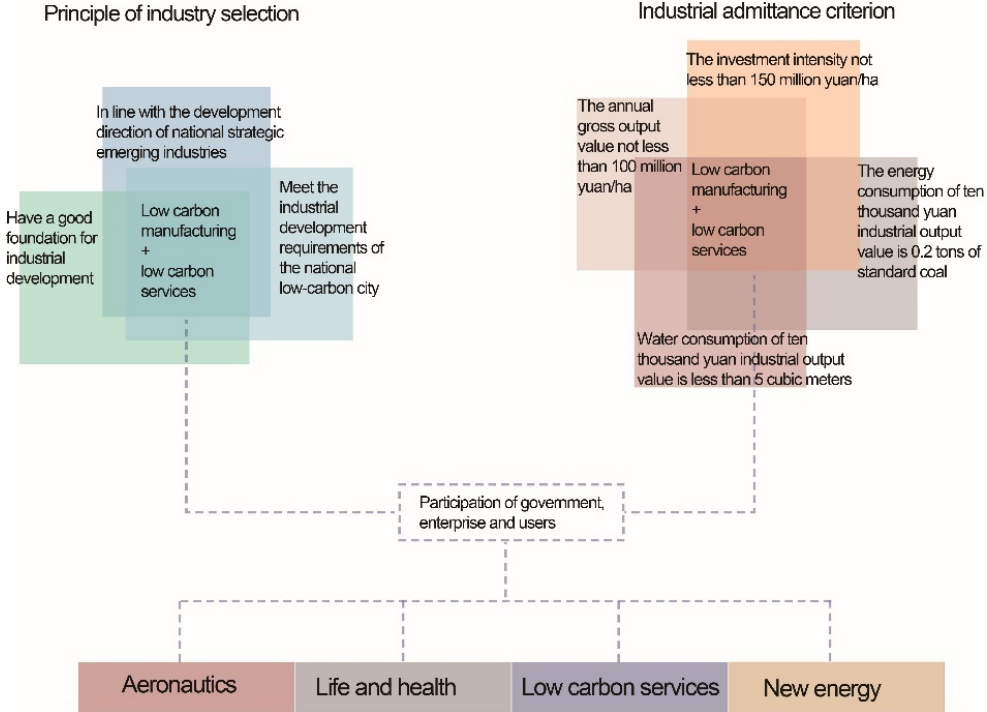
Figure 10. Industrial operation principle and industrial access criterion (Source: author).